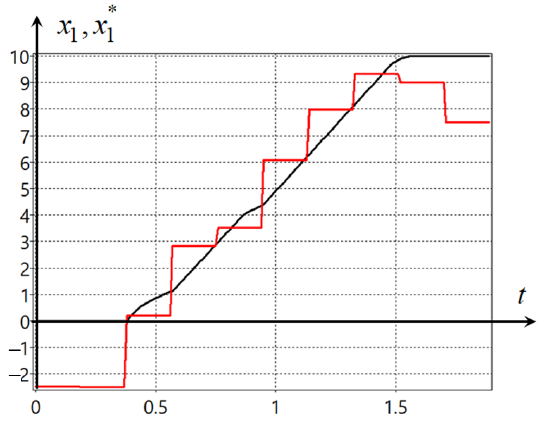
Figure A1. Plots of optimal x 1 and x 1 ∗